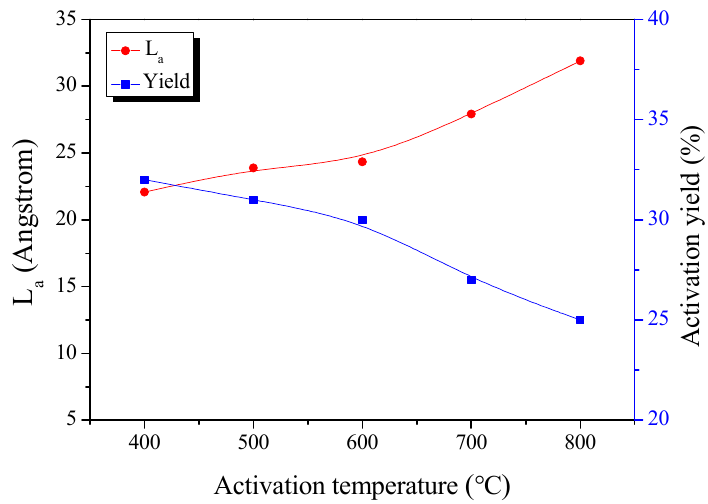
Figure 3. Structural characteristics of kenaf-derived activated carbons as a function of various phosphoric acid activation temperature.